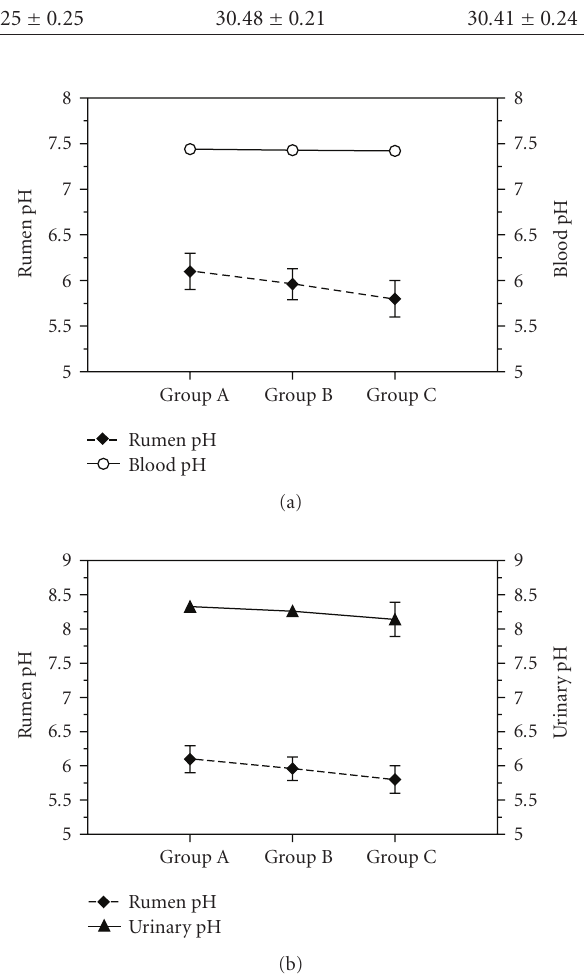
Figure 1: Graphical representation of the trends of rumen pH and blood pH (a) and rumen pH and urinary pH (b), in three experimental groups (group A, B and C), each composed of 72 dairy cows, which di ff ered for Ruminal